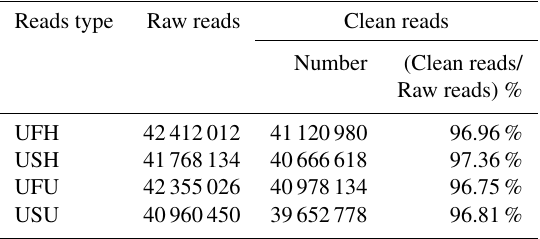
Table 1. Percentage and distribution of sequencing results in UF vs. US